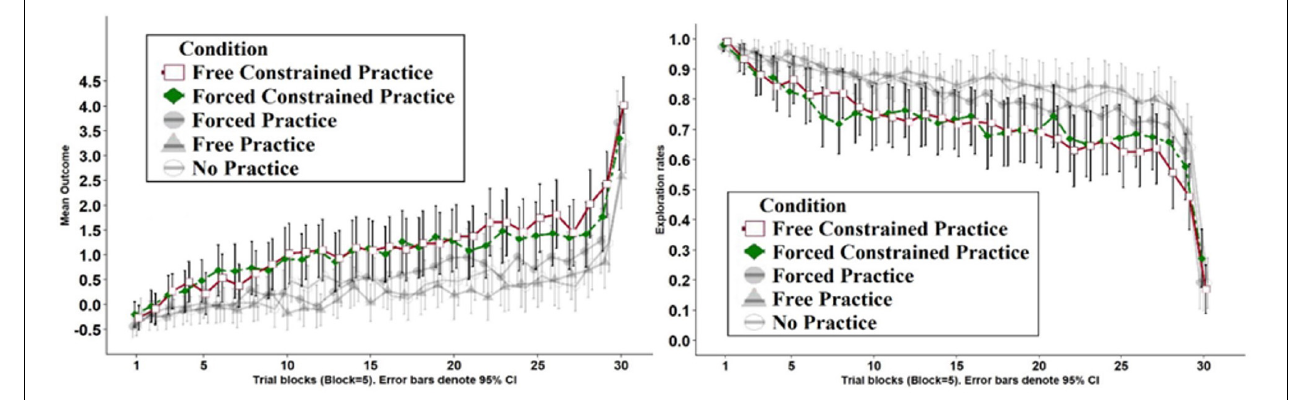
FIGURE 3 | Left: mean outcome in trial blocks in Game 2 (each block equals five trials), across the two Conditions of Study 2. Right: choice rates implying choice of unexplored keys in Game 2 (each block equals five trials), across the two Conditions of Study 2. Shaded lines present the three Conditions of Study 1 for